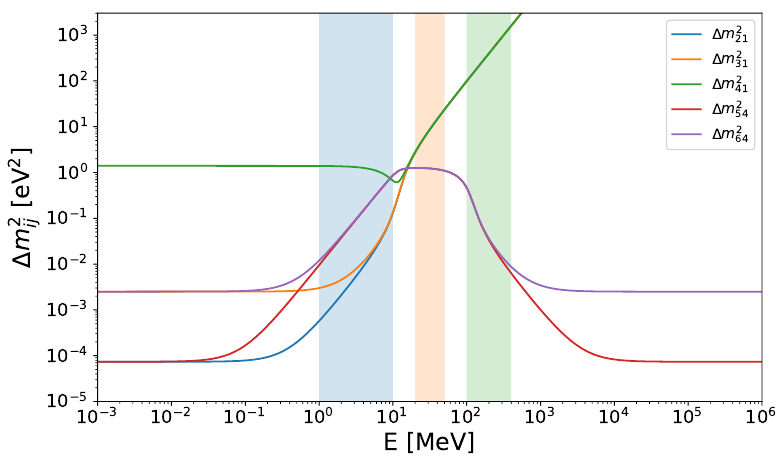
Figure 5 . E(cid:11)ective mass splittings (cid:1) m 2 as a function of the energy. The new parameters are ij (cid:12)xed to the values from \set 2" in table 2. For the other set of parameters the picture looks very similar. The shaded region indicates the energy range relevant for reactor neutrino experiments (blue), LSND (orange) and MiniBooNE (green).